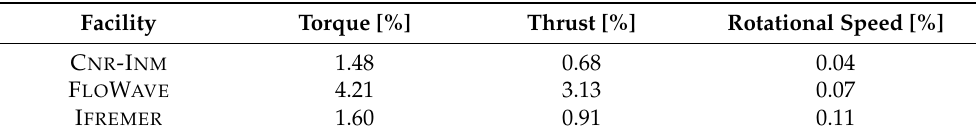
Table 9. Comparison of the combined expanded uncertainty as a percentage of the average value based on Equations (1) and